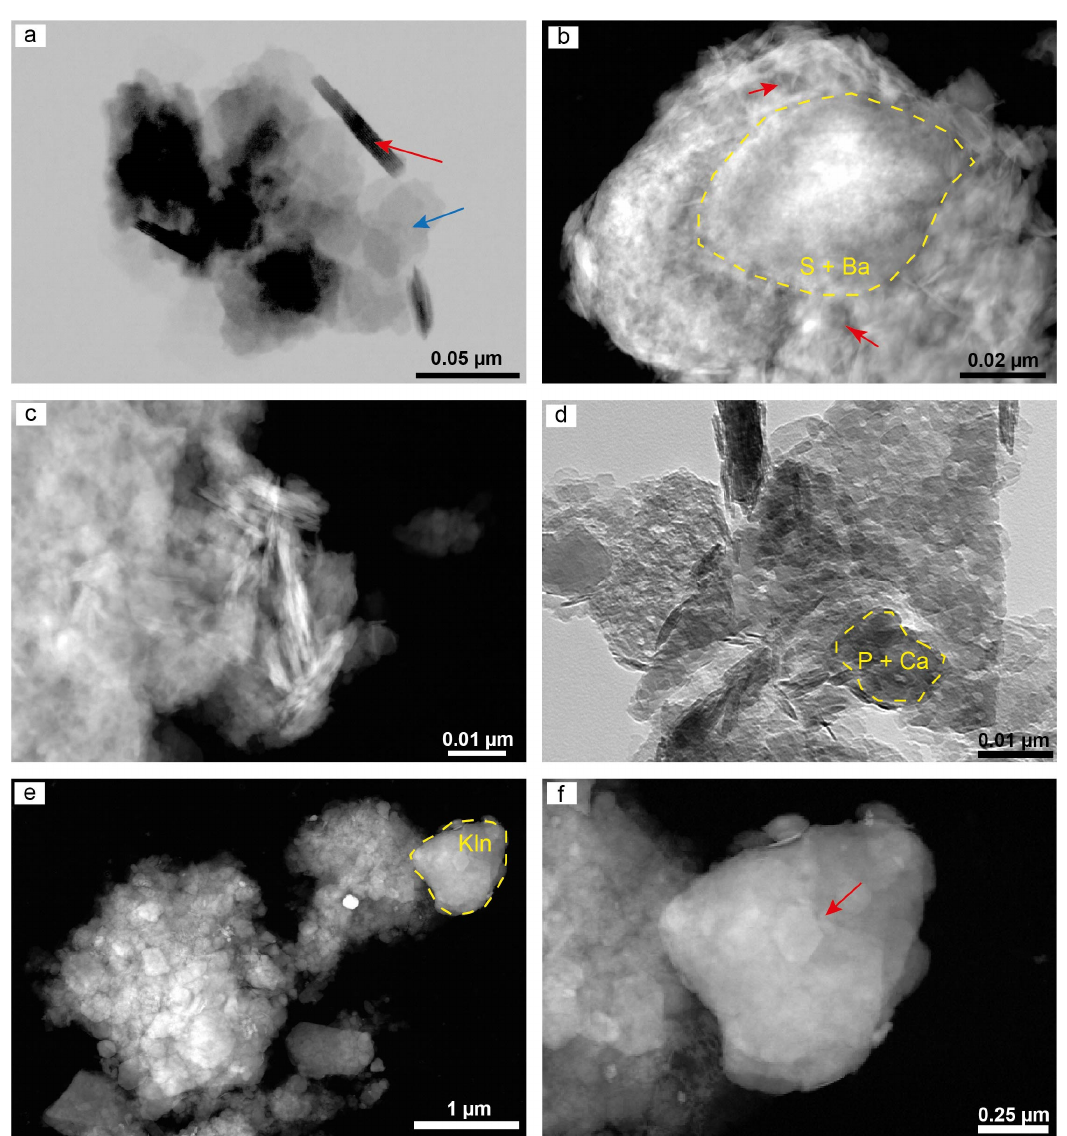
Figure 8. Transmission electron photomicrographs. ( a ) Lath-like clay particles (red line) and flakes (blue line) in the same aggregate; ( b ) “cotton-like” clays with filamentous pore-lining (red arrows) bond in the core (yellow dashed line) composed of S and Ba; ( c ) “cotton-like” clays associated with elongated clays; ( d ) different types of morphologies of clay minerals. The yellow dashed line indicates a portion rich in Ca and P; ( e ) aggregation of “cotton-like” and pseudohexagonal clays. The circulated area (yellow dashed line) is composed mainly of Si and Al, comprising kaolinite; ( f ) detail of the pseudohexagonal kaolinite. Kln—kaolinite.